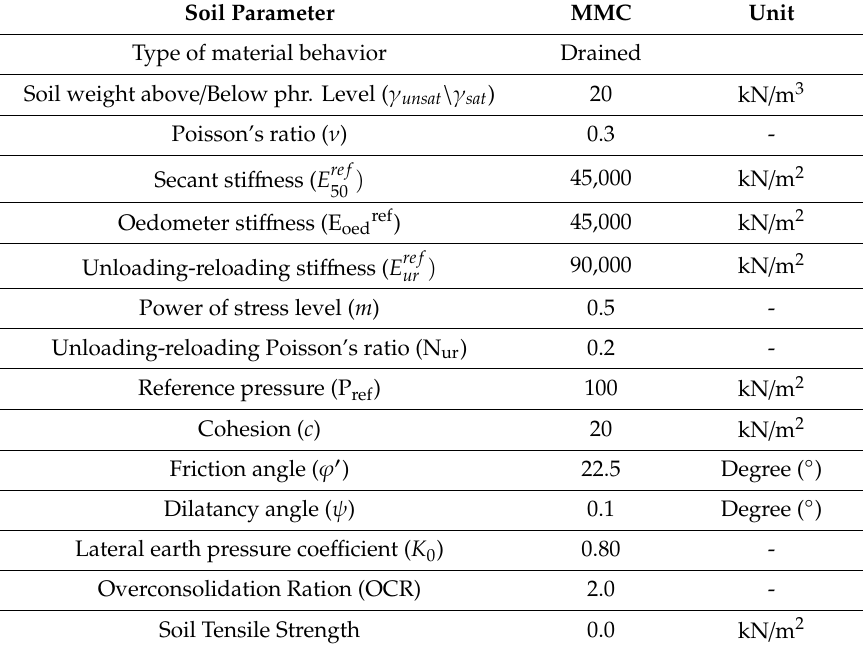
Figure 9. (2D) axisymmetric finite element model established based on the results of the sensitivity analysis performed (After [10]). Table 1. Over-consolidated sti ff clay soil (drained parameters) (After